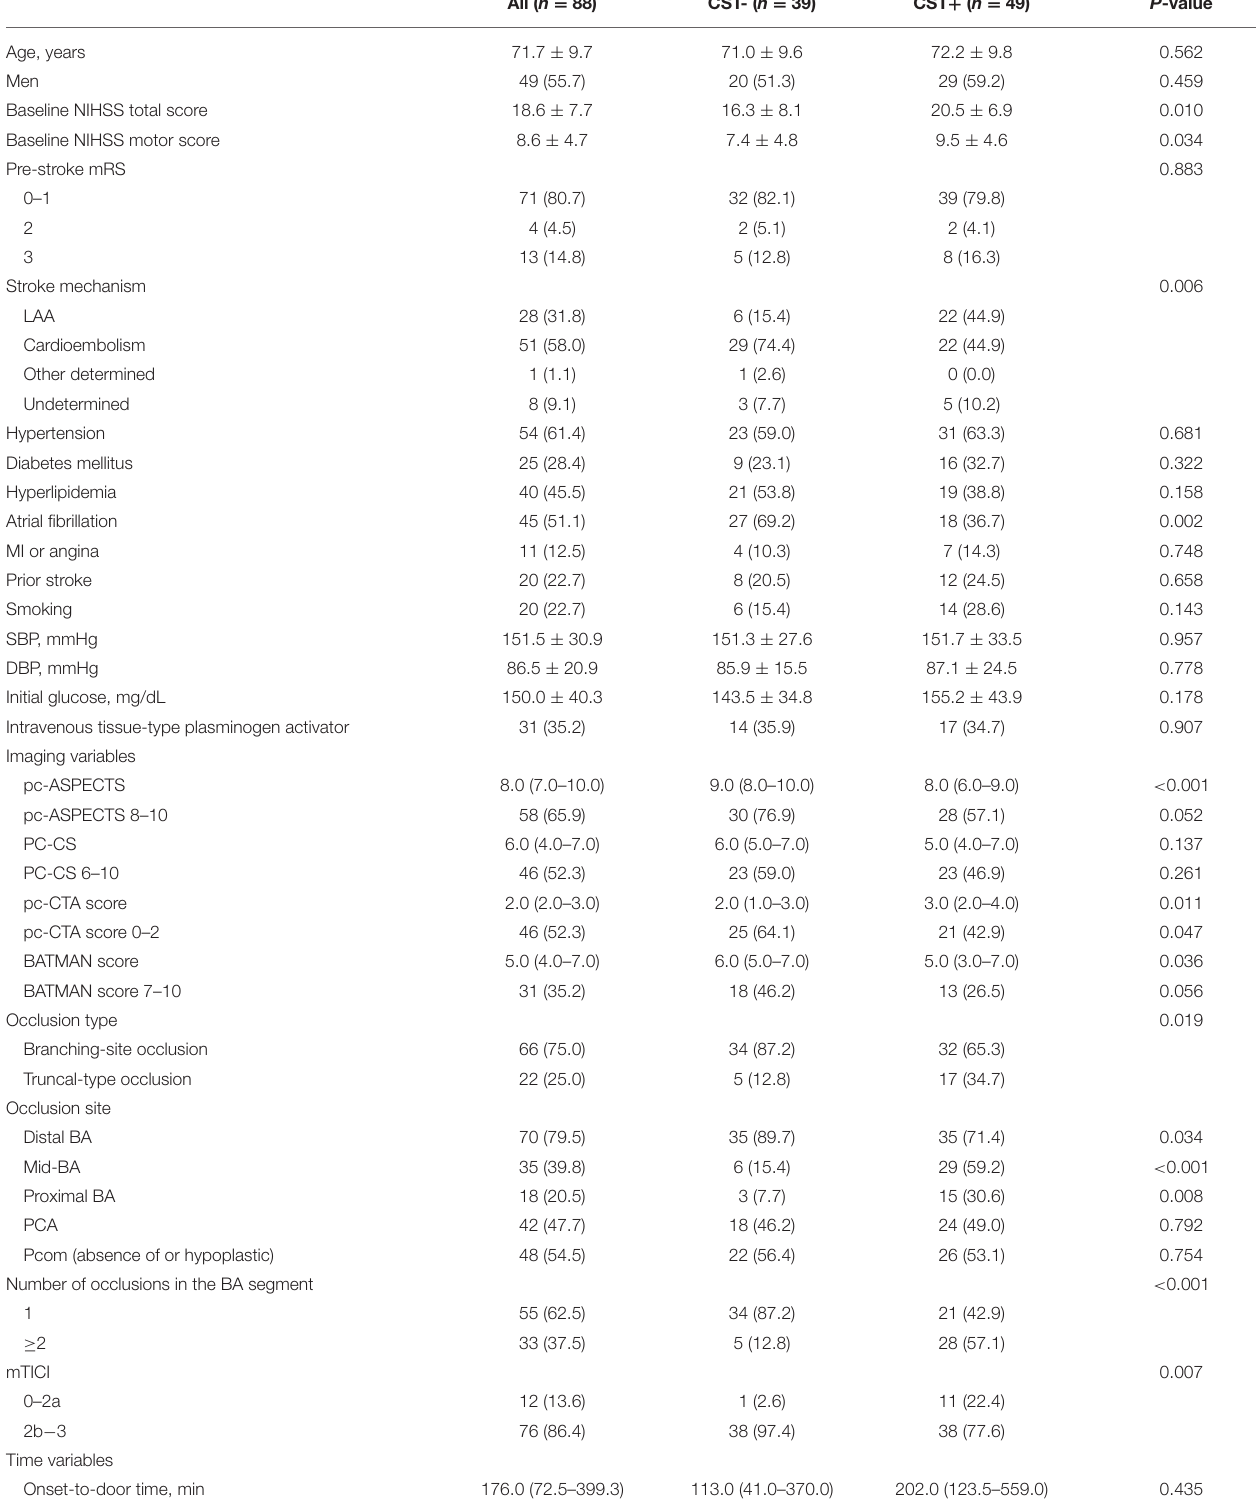
TABLE 1 | Baseline characteristics according to the corticospinal tract